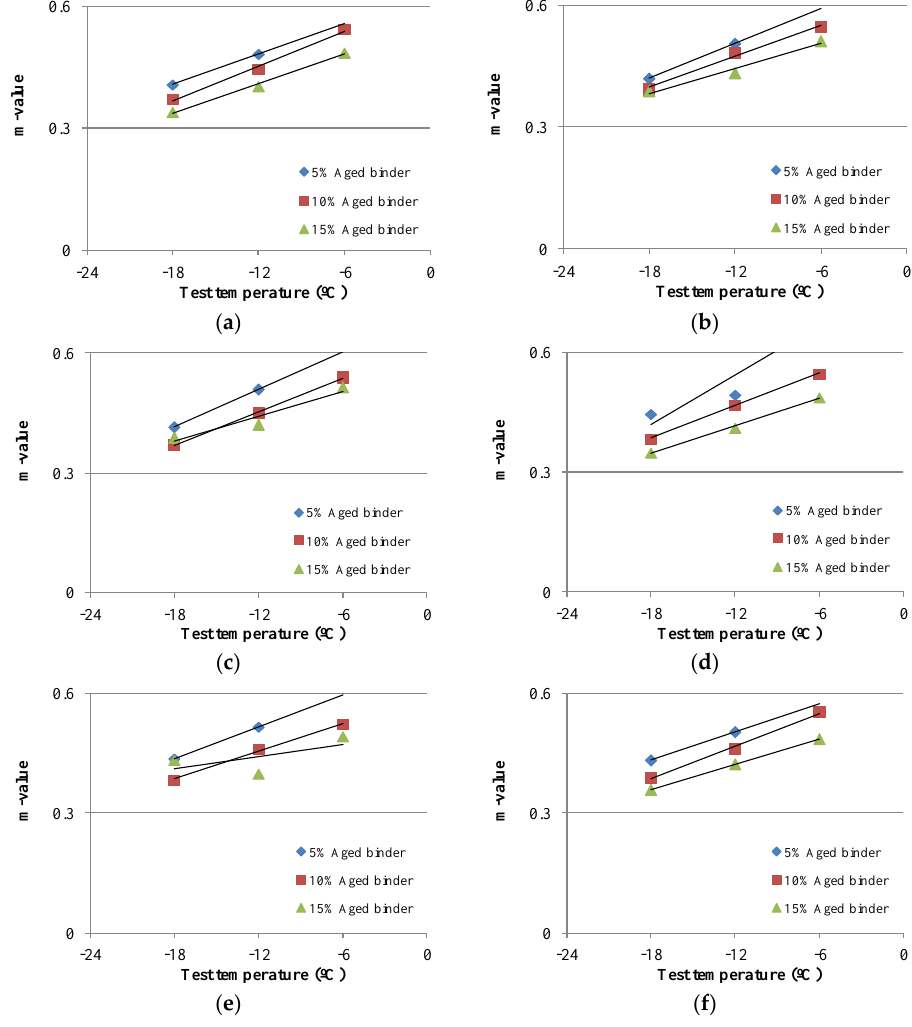
Figure 3. Low temperature determinations of RAP sources A–F with virgin binder PG 58-28 in terms of m-value, ( a – f ) RAP sources A–F.